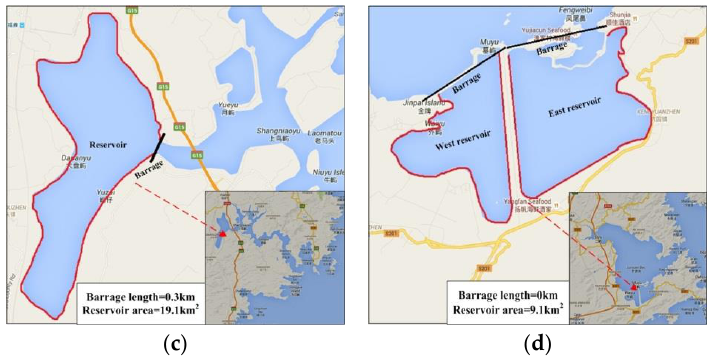
Figure 3. The shapes of the reservoir and estuary of the four TPP sites: ( a ) Huangdun harbor TPP; ( b ) Jiaotiao harbor TPP; ( c ) Bachimen TPP; ( d ) Daguanban TPP.